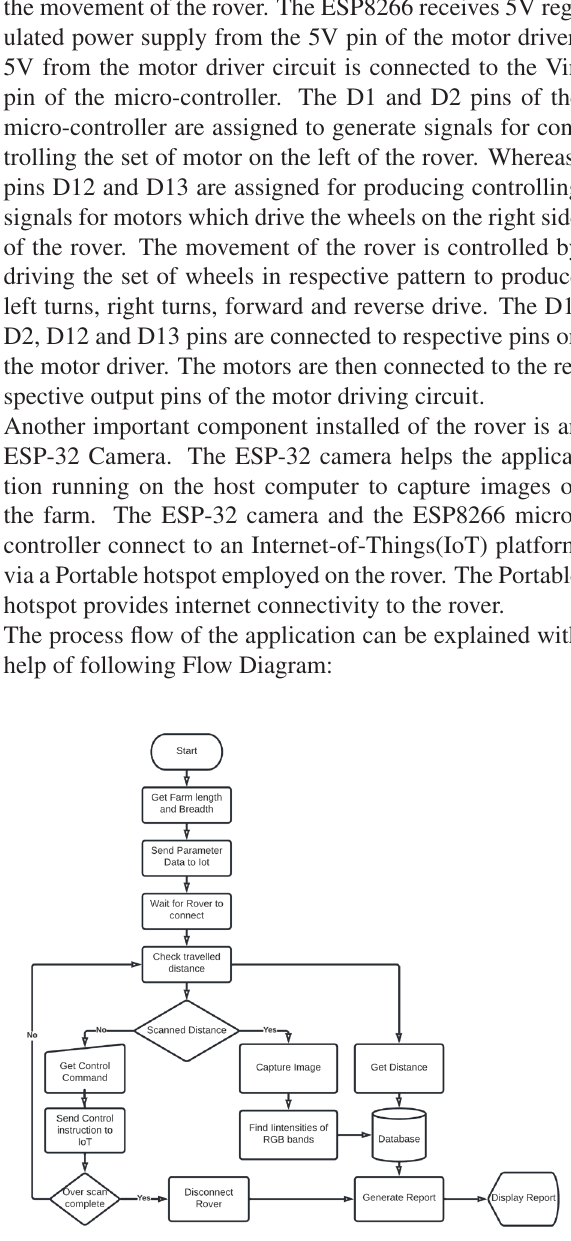
Figure 1. Block Diagram of System